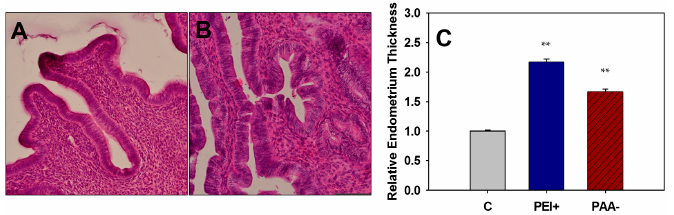
Figure 4. Hematoxylin and eosin stained uterine sections from adult control mice ( A ) or those exposed to 100 mg/kg of iron oxide NPs in utero ( B ) (magnification of A , B : 200×). Relative endometrial thicknesses ( C ) were measured for all treatment groups exposed to 100 mg/kg iron oxide NPs in utero and the control, C, with GD 8, 9, or 10 pooled for all analyses. ** Significant differences between treatment group and the control ( p < 0.01).